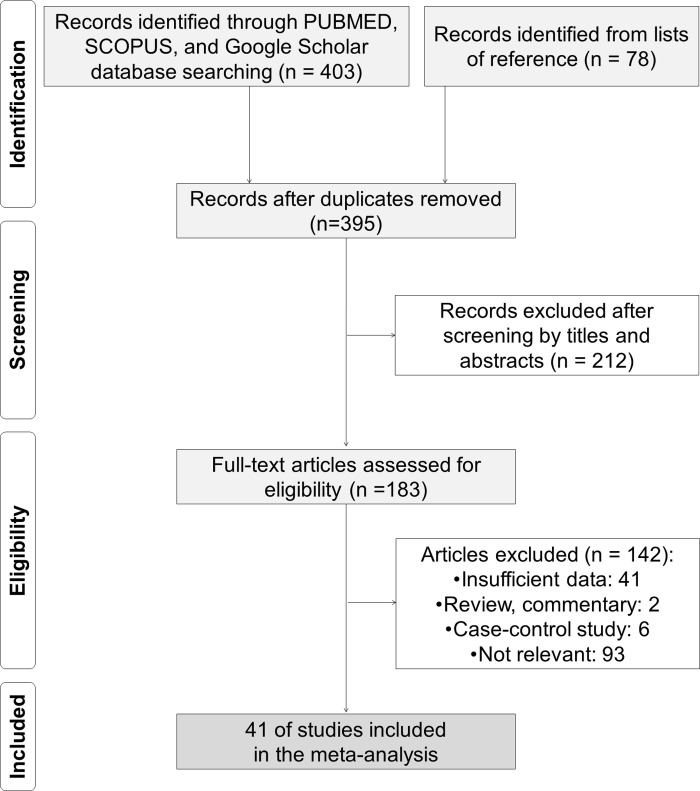
Flow diagram of the literature search and selection of studies for the meta-analysis.